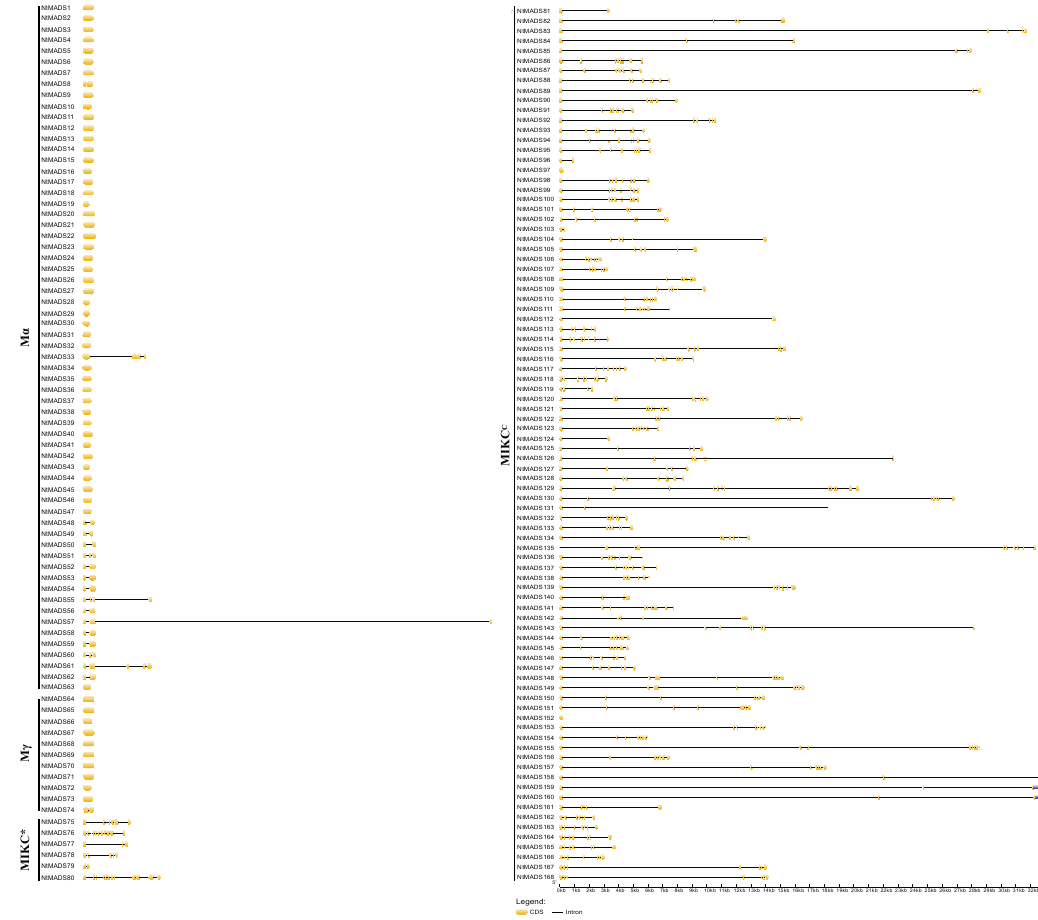
Figure 2. Gene structure of the NtMADS-box gene family in tobacco. Exon–intron analyses of identical tobacco NtMADS-box genes were performed with GSDS 2.0. Exons and introns are represented by black rectangle and black lines, respectively. The lengths of exons and introns for each tobacco NtMADS-box gene are shown proportionally.